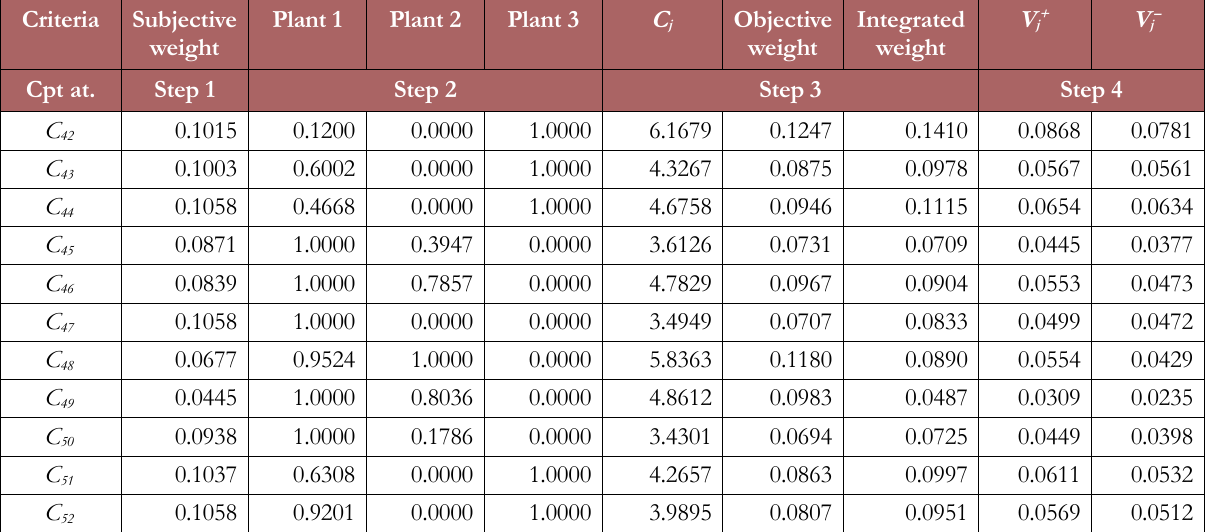
Table 11. Computation of rough BWM-CRITIC-TOPSIS (IoT)